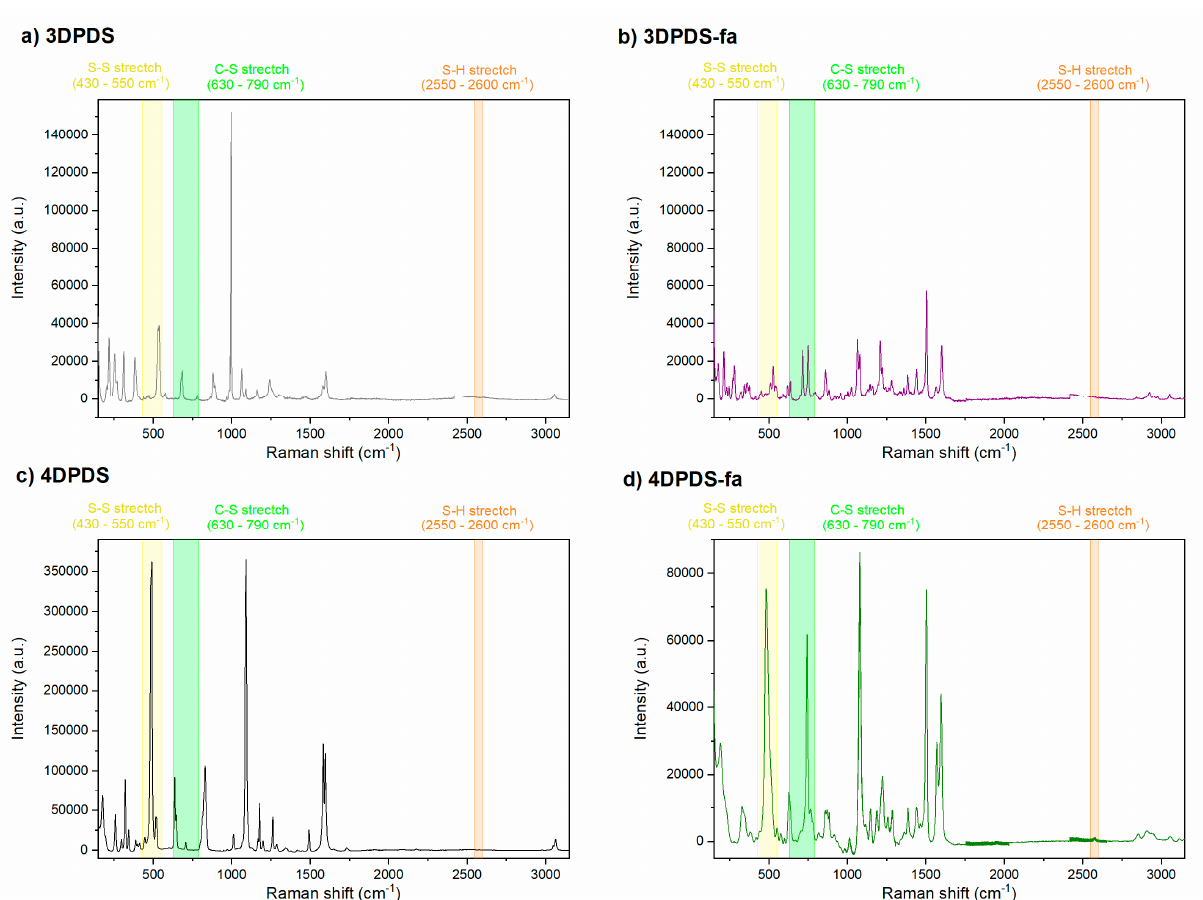
Figure A6. FTIR spectrum of 3DPDS-fa.